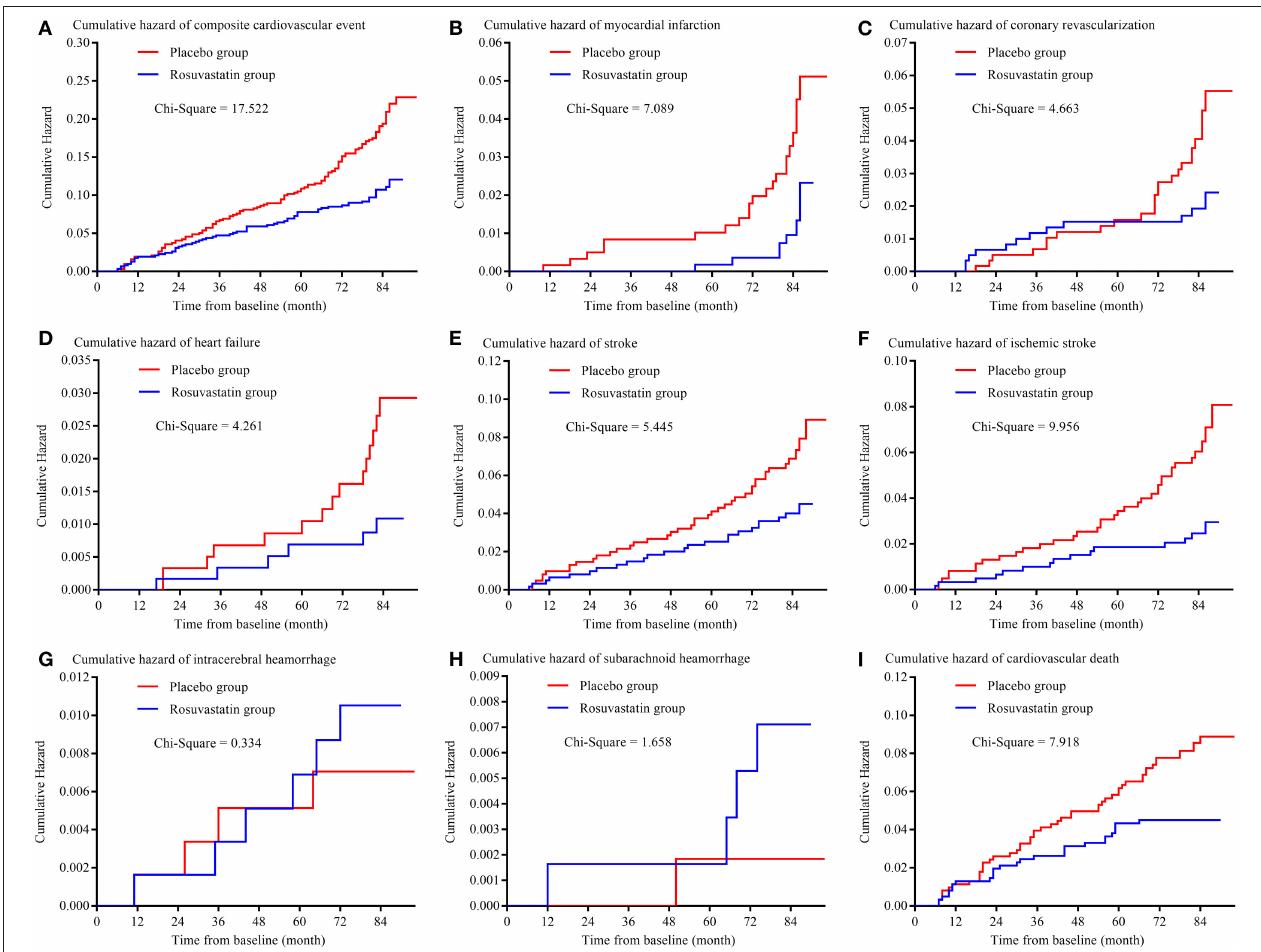
FIGURE 2 | Kaplan-Meier curve of primary outcomes. (A) is the Kaplan-Meier curve of composite cardiovascular event; (B) is the Kaplan-Meier curve of myocardial infarction; (C) is the Kaplan-Meier curve of coronary revascularization; (D) is the Kaplan-Meier curve of heart failure; (E) is the Kaplan-Meier curve of stroke; (F) is the Kaplan-Meier curve of ischemic stroke; (G) is the Kaplan-Meier curve of intracerebral hemorrhage; (H) is the Kaplan-Meier curve of subarachnoid hemorrhage; (I) is the Kaplan-Meier curve of cardiovascular death.